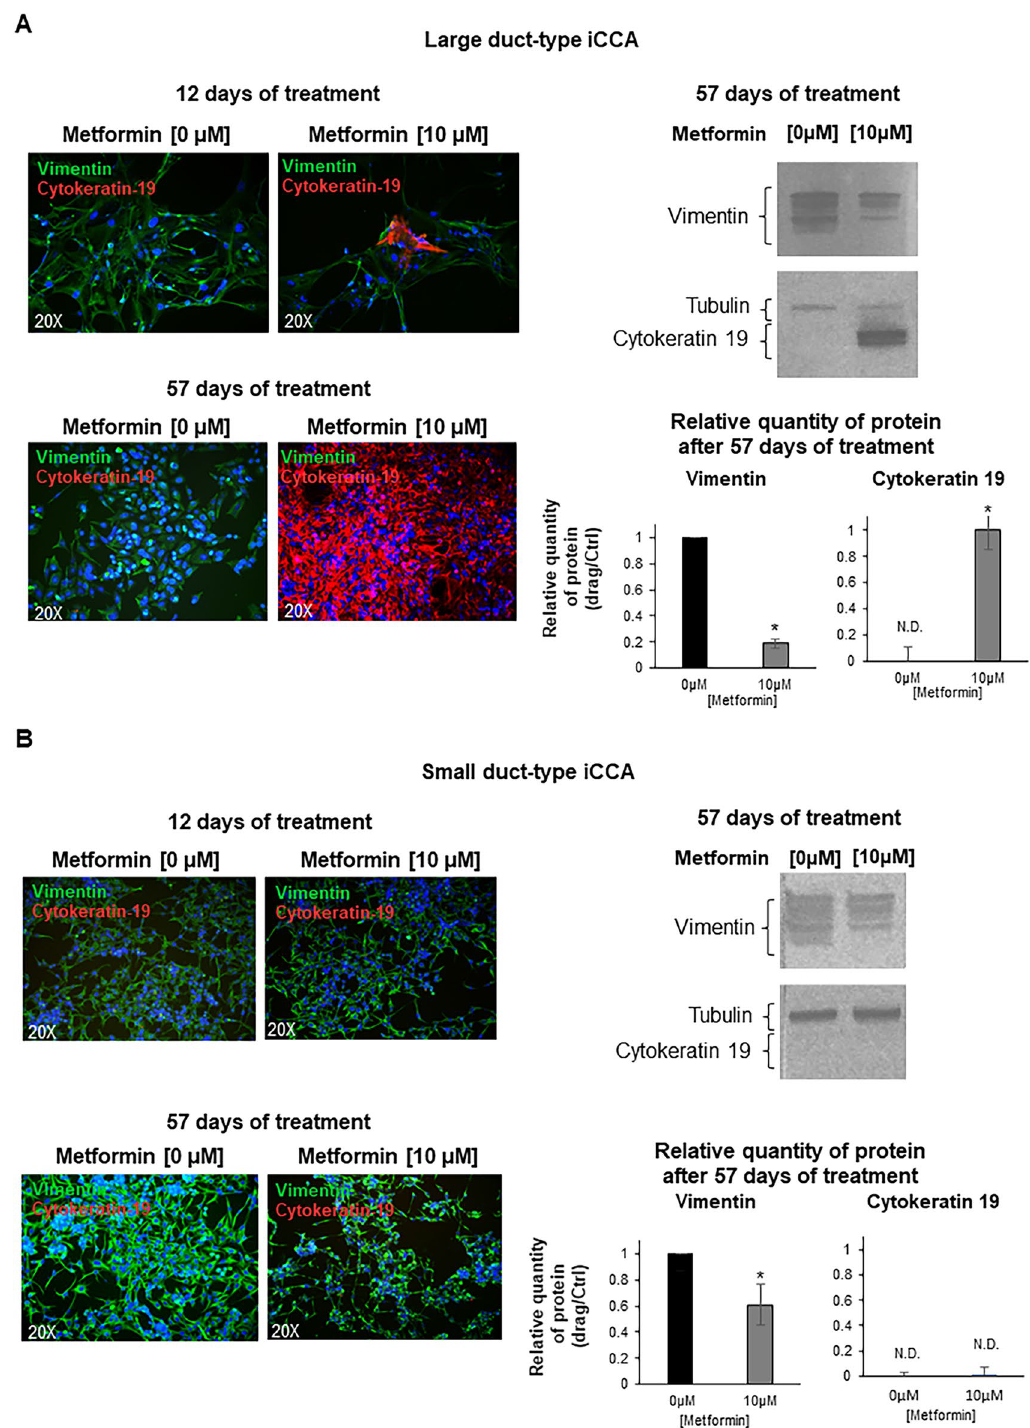
Figure 6. IF and western blot analysis of Vimentin and Cytokeratin-19 in primary cultures of Large duct- type iCCA treated for 12 or 57 days with Metformin. ( A ) Vimentin and Cytokeratin-19 were analysed by IF (left panels), in Large duct-type iCCA primary cultures treated with Metformin 10 µM for 12 and 57 days. Metformin induced a marked IF positivity for Cytokeratin-19 and a marked decrease of Vimentin expression that were not observed after 48–96 h of treatment. By western blot (right panels, cropped gels/blots are displayed), the protein expression of Vimentin decreased while that of Cytokeratin-19 increased after prolonged (12 and 57 days) treatment with Metformin 10 µM. * p < 0.05 versus controls. Data represent mean ± SD of N = 3 independent experiments. ( B ) In contrast with Large duct-type iCCA, in the Small duct-type iCCA cells the Cytokeratin-19 expression was not observed neither by IF not by western blot (not detectable, ND). However, by western blot analysis a decreased level of Vimentin was observed. * p < 0.05 versus controls. Mean ± SD of N = 3 independent